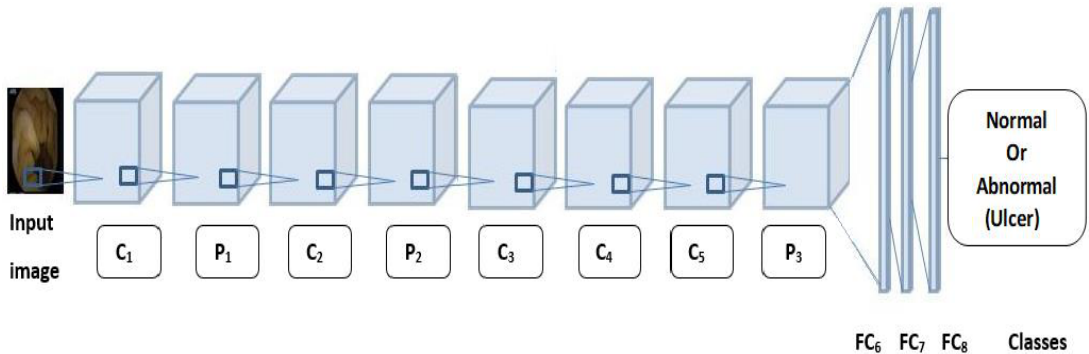
Figure 2. AlexNet architecture with five convolutional and max pooling layers and three fully connected layers for ulcer image detection.